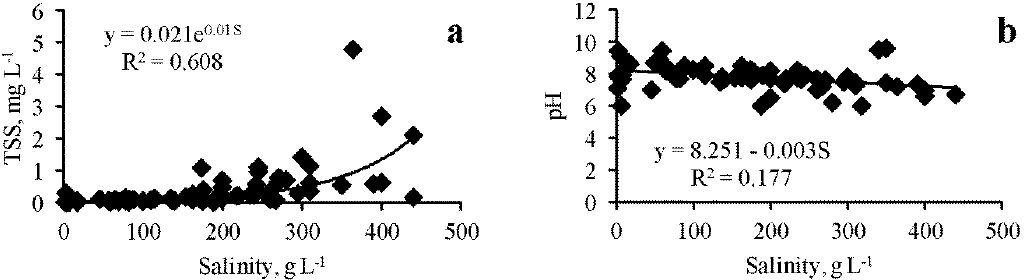
lakes (( a ) — TSS dependence, ( b ) — pH dependence). lakes (( a )—TSS dependence, ( b )—pH